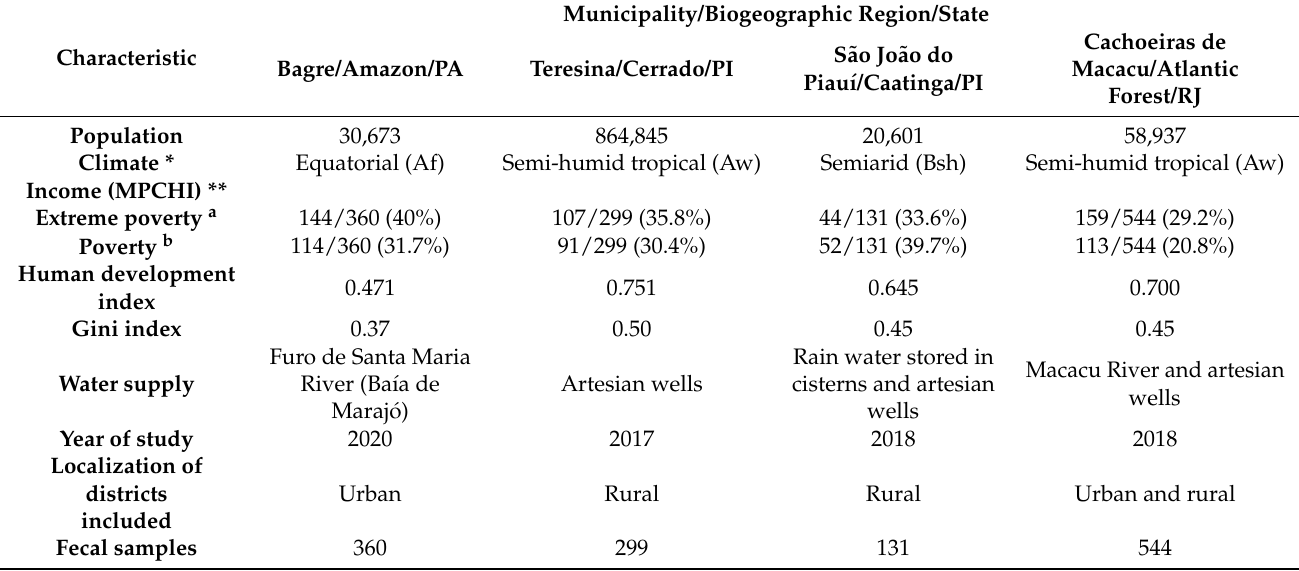
Table 1. Socio-environmental characteristics of the different studied localities.